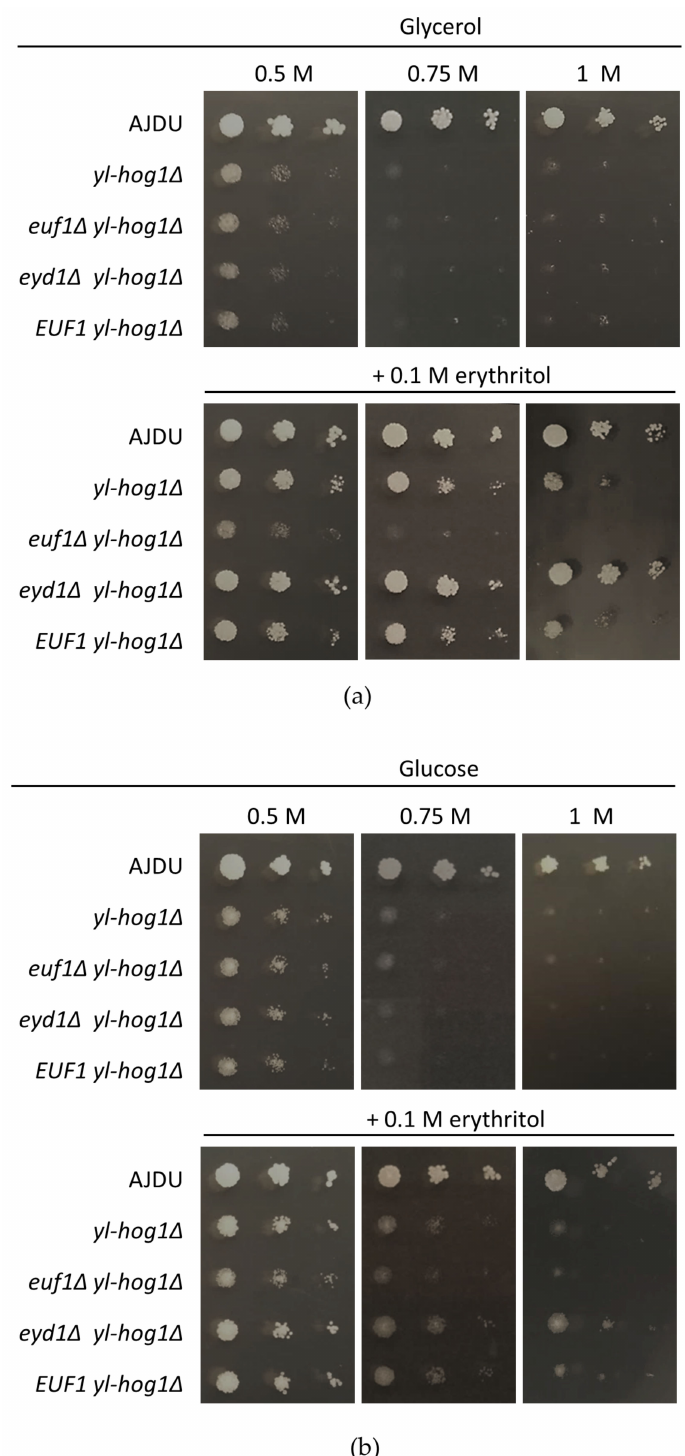
Figure 5. Growth of Y. lipolytica AJDU, yl-hog1 ∆ , euf1 ∆ yl-hog1 ∆ , eyd1 ∆ yl-hog1 ∆ and EUF1 yl-hog1 ∆ after 48 h of incubation on YNB agar plates with glycerol ( a ) or glucose ( b ) as the main carbon source and supplementation with